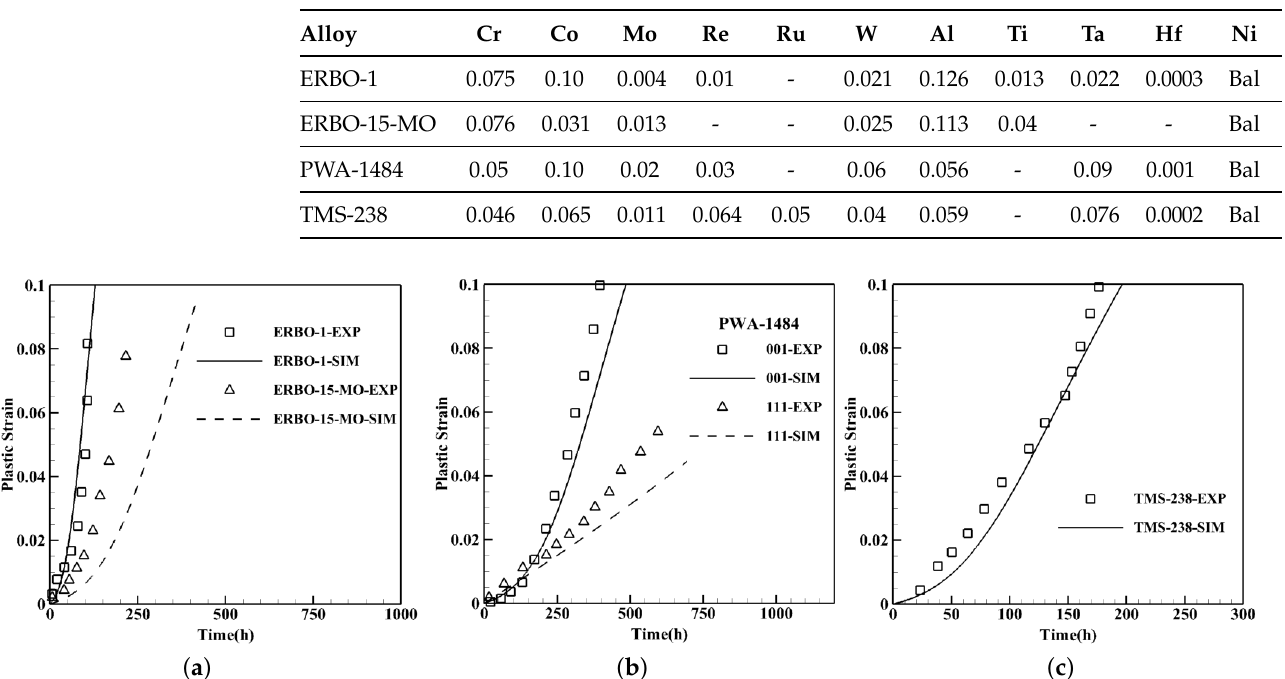
Table 3. Nominal chemical composition (mass fraction) for four generations of single-crystal nickel- based superalloys.